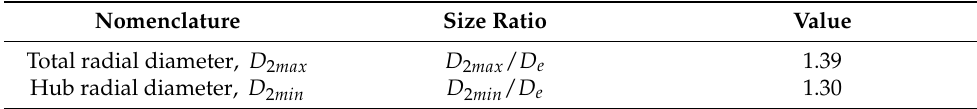
Table 2. Specification of screw centrifugal pump model